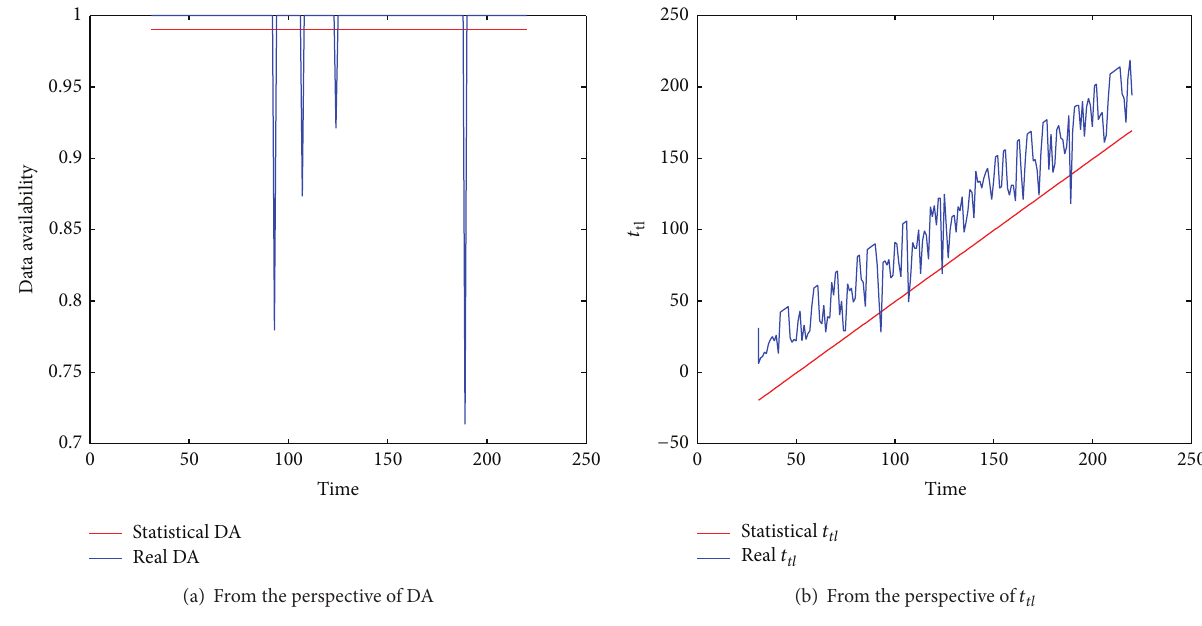
Figure 6: The accuracy of the DA model.